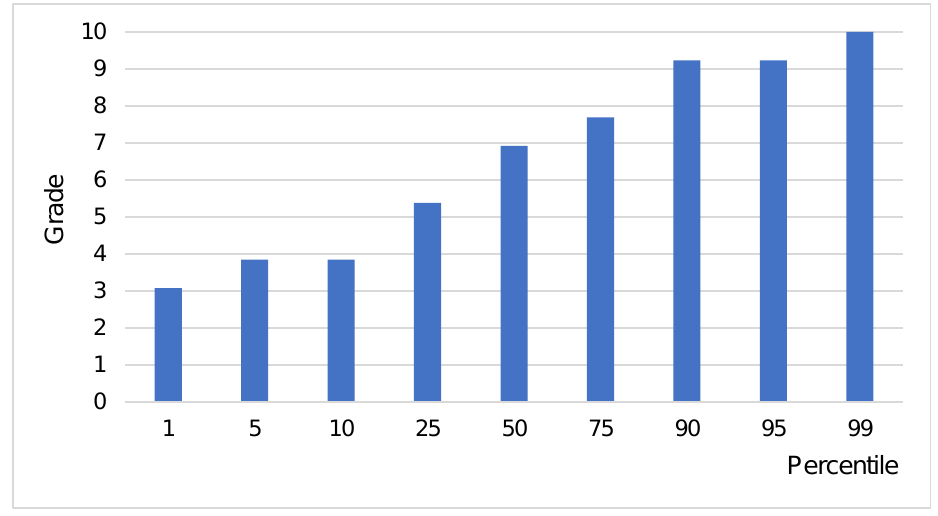
Figure 6. Percentile distribution of the students ’ grades during the diagnostic test before the training in the platform.